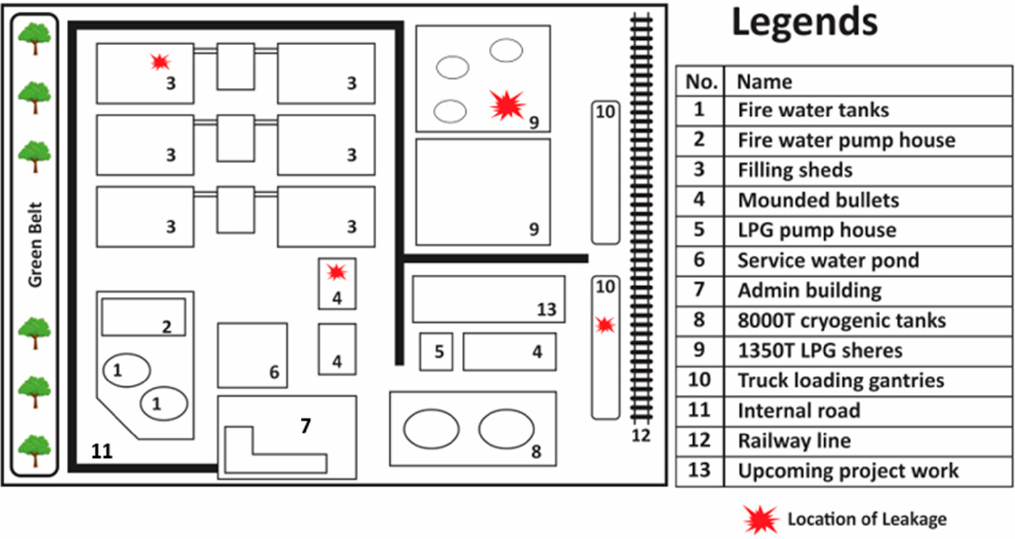
Figure 2. Block diagram of LPG terminal layout .